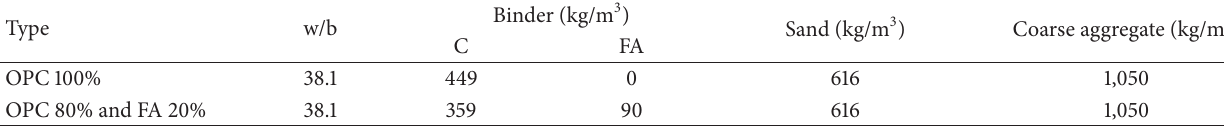
Table 6: Mix proportions for verification (long-term submerged